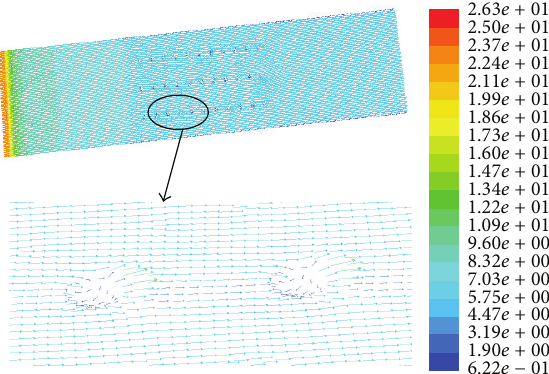
Figure 12: Velocity vector of dimple bionic nonsmooth surface.